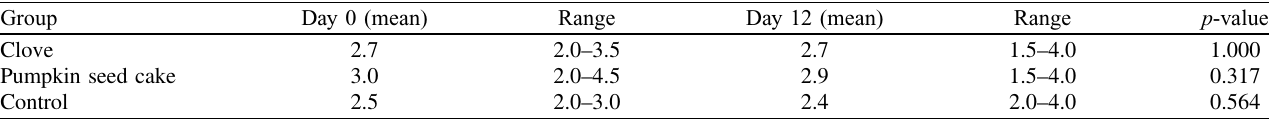
Table 2. Body condition score before (day 0) and after supplementation (day 12).